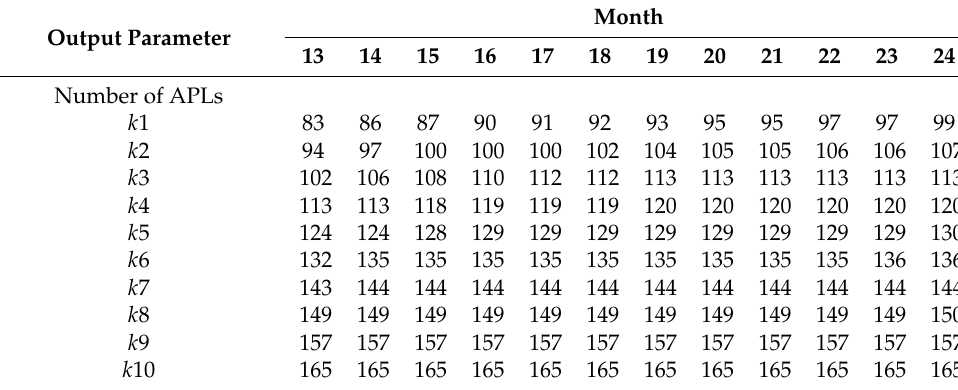
Table A5. Number of APLs in the second year.